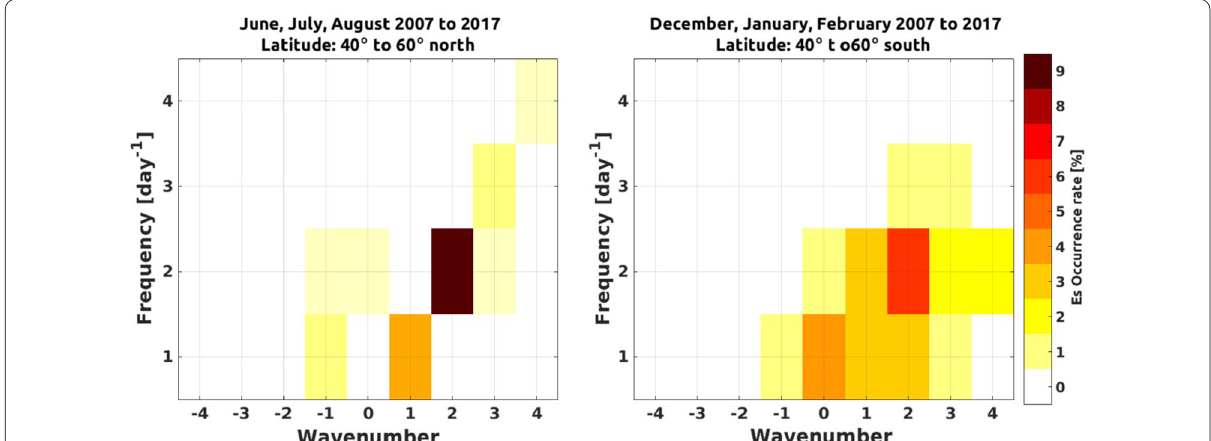
Fig. 3 Solar tidal spectra of mid‑latitude EsOR amplitude during northern hemisphere summer (left) and southern hemisphere summer